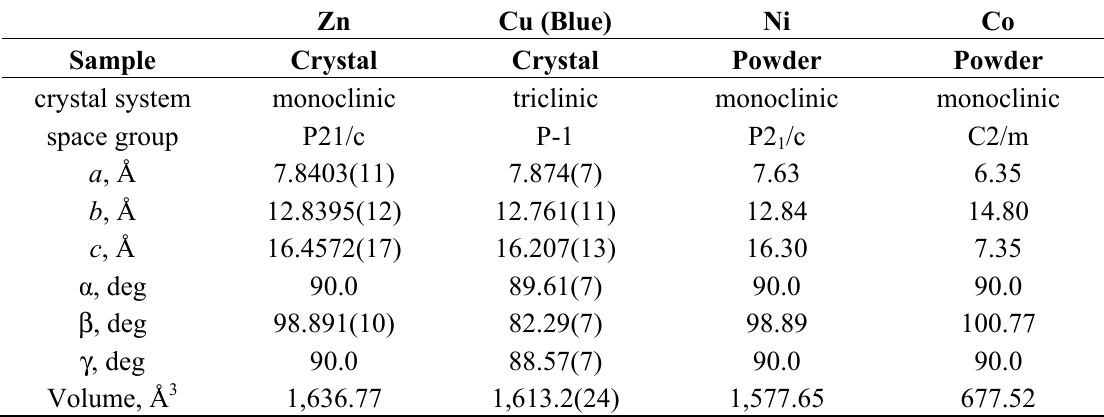
Table 4. Unit cell parameters determined for the M[Au(CN) polymers (M = Zn, Cu (blue polymorph), Ni and Co), by either single crystal or powder X-ray